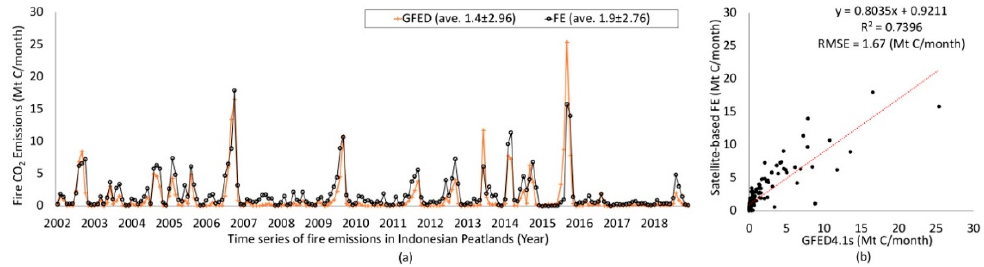
Figure 11. As a result, the FE values were higher in Sumatra and Kalimantan of Indonesia and Borneo of Malaysia than the other regions. Remote Sens. 2019 , 11 , x FOR PEER REVIEW